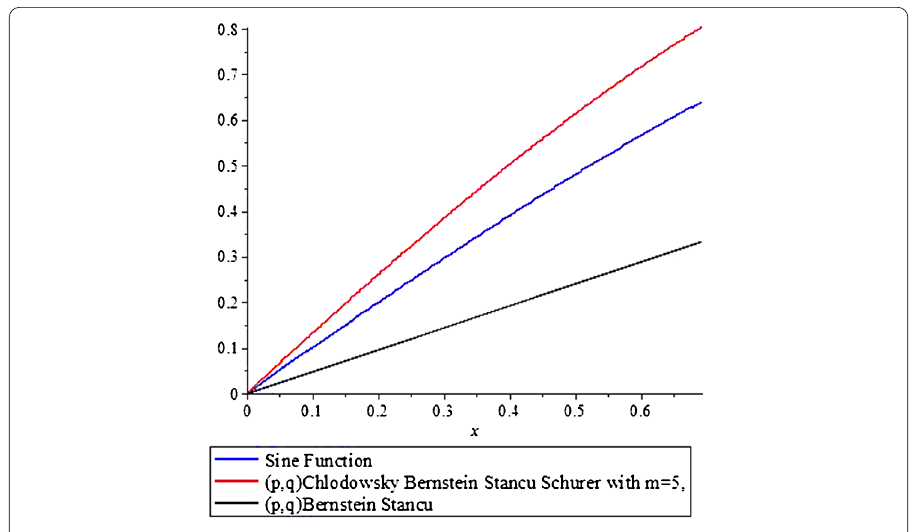
Figure 1 Comparison of ( p , q ) Chlodowsky type Bernstein-Stancu-Schurer operators and ( p , q ) Bernstein-Stancu operators for Sin( x